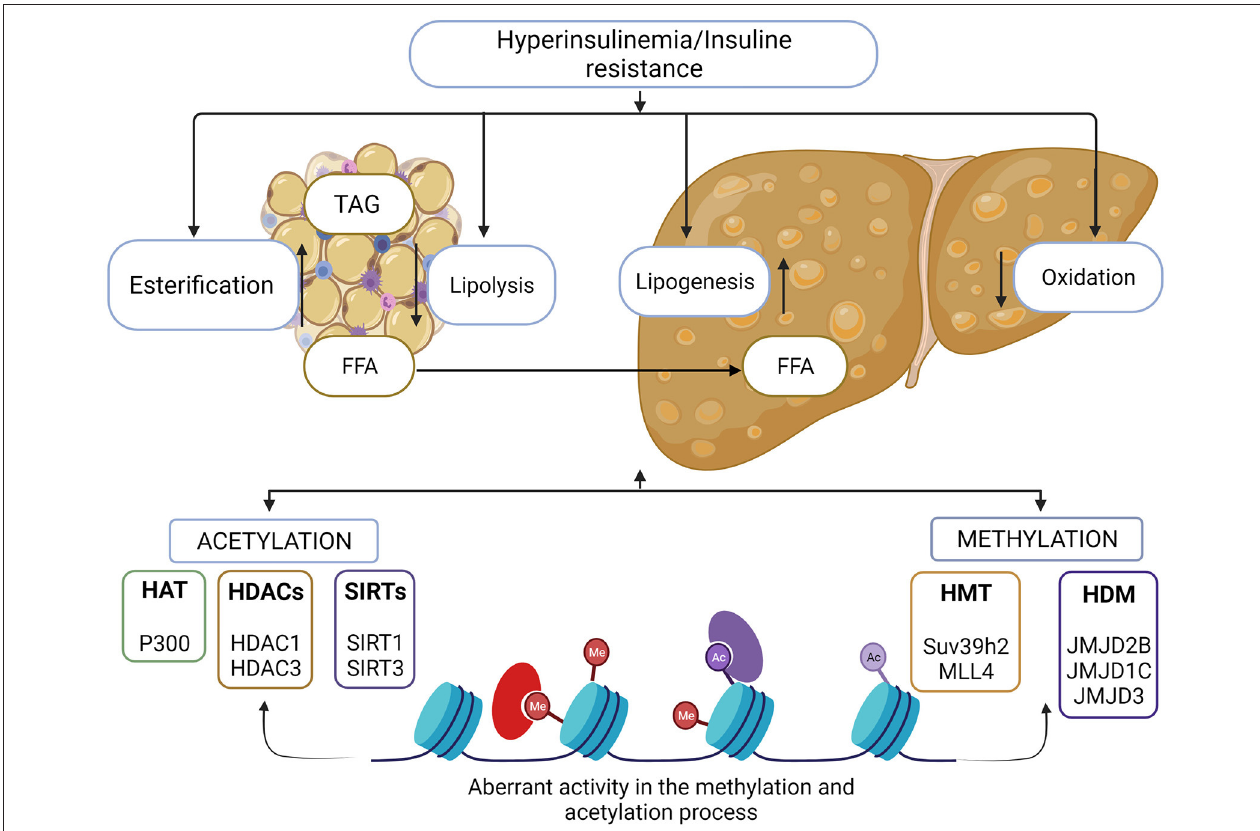
FIGURE 2 | Histone modifications in MAFLD. Metabolic imbalance in lipids and carbohydrates are involved in the development of MAFLD. Adipose tissue storage and insulin resistance triggers the accumulation of free fatty acids in the liver and liver homeostasis is lost. There is a direct association between aberrant chromatin modifications and this metabolic imbalance. Histone methylation and acetylation process, allows the activation of genes associated with the lipogenic and inflammatory process, as well as the reduction in expression of the genes involved in the oxidation of fatty acids, enzymes responsible for these events are possible therapeutic target for MAFLD